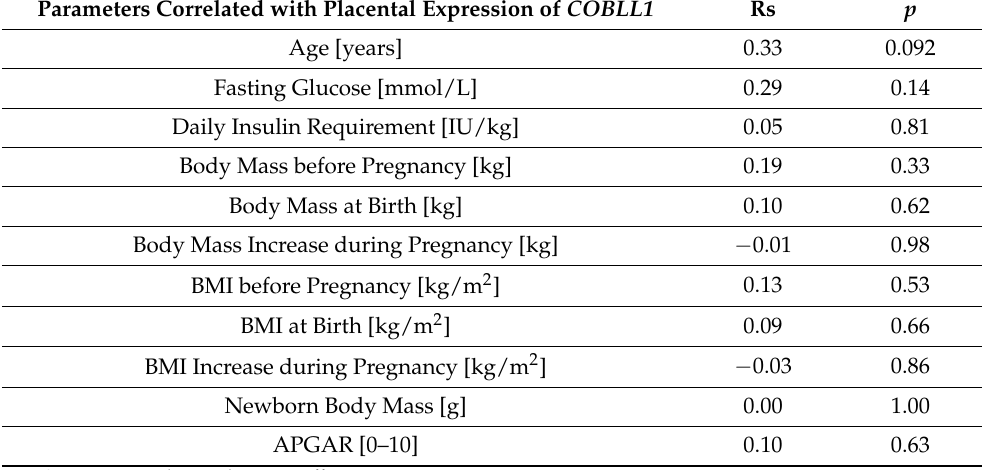
Table 4. Correlations between COBLL1 expression in the placenta and clinical parameters in the GDM group ( n = 27). Parameters Correlated with Placental Expression of COBLL1